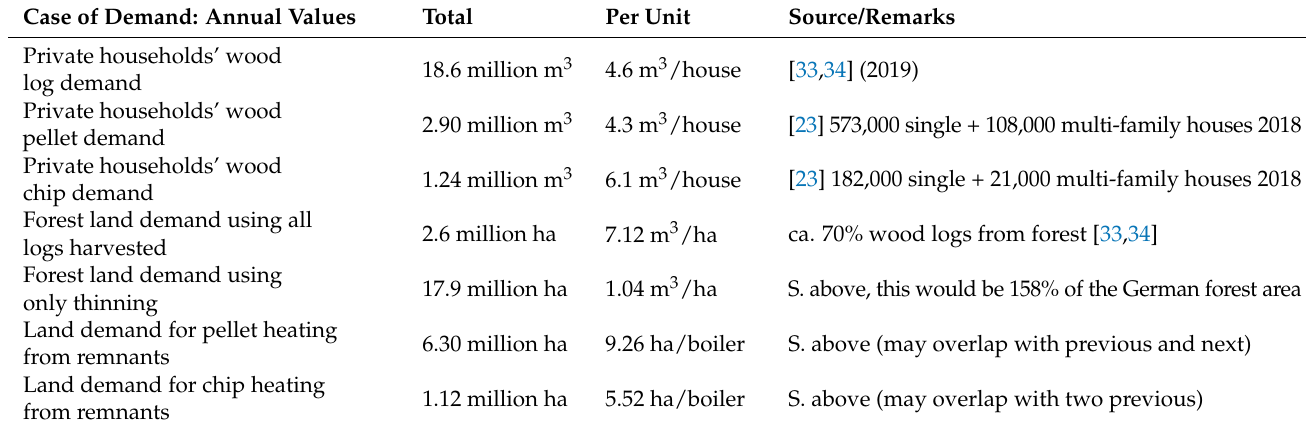
Table 3. Use cascade of timber and firewood from forestry or wood production residues in pri- vate